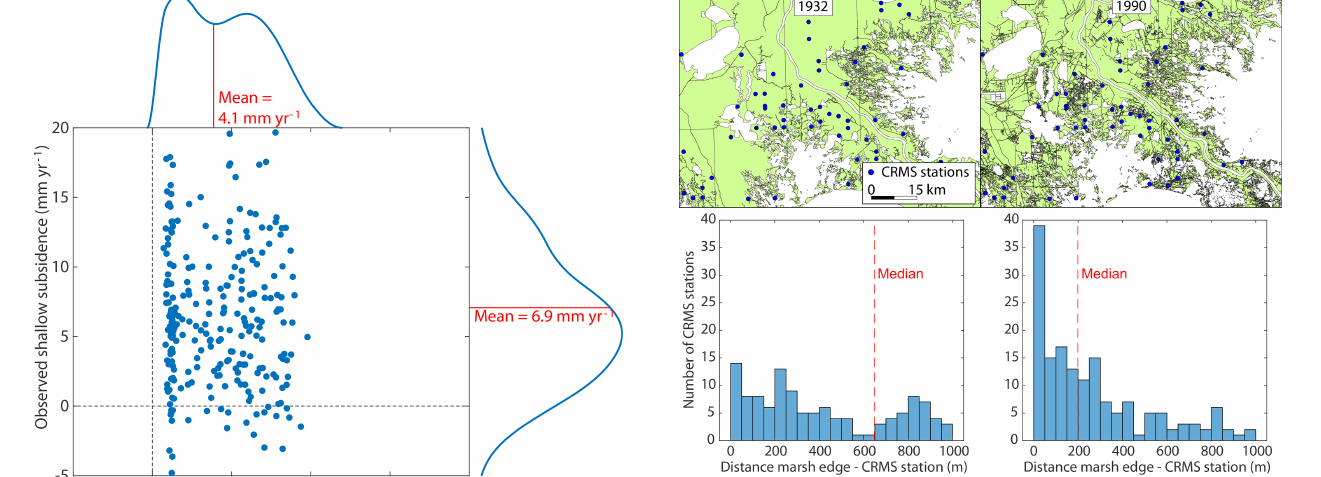
Figure 4. MRD land area map for 1932 and 1990, based on Pen- land et al. (2000), including CRMS stations, and average distance of CRMS stations to the marsh